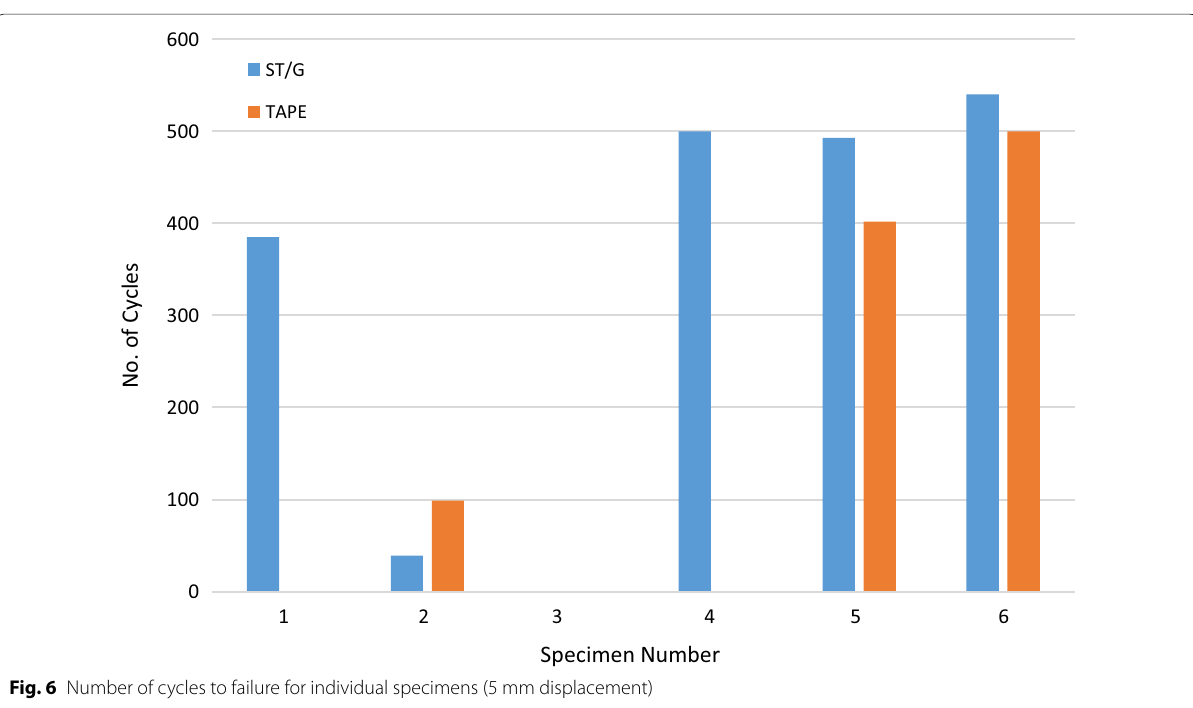
Fig. 6 Number of cycles to failure for individual specimens (5 mm displacement)